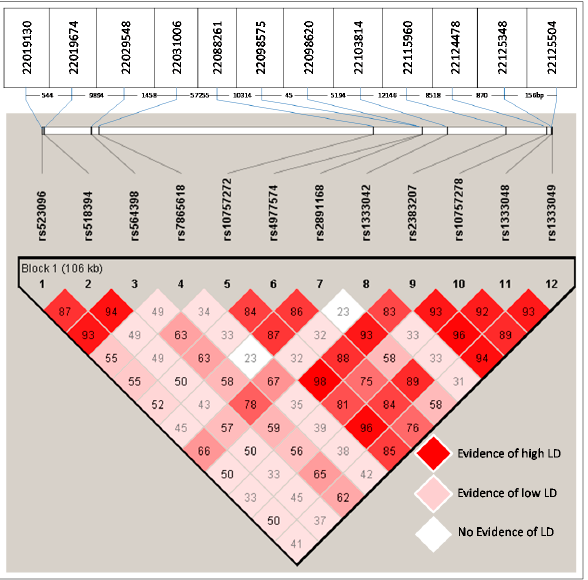
Figure 2. The chromosomal positions of the 12 SNPs analyzed in 9p21 locus and their LD. Upper table : Indicating the coordinates according to the reference sequence NT_008413.18. Middle row : indicates the distance (bp) between two adjacent SNPs. Lower half : Indicating the D’ value in each diamond among 12 SNPs in 9p21.